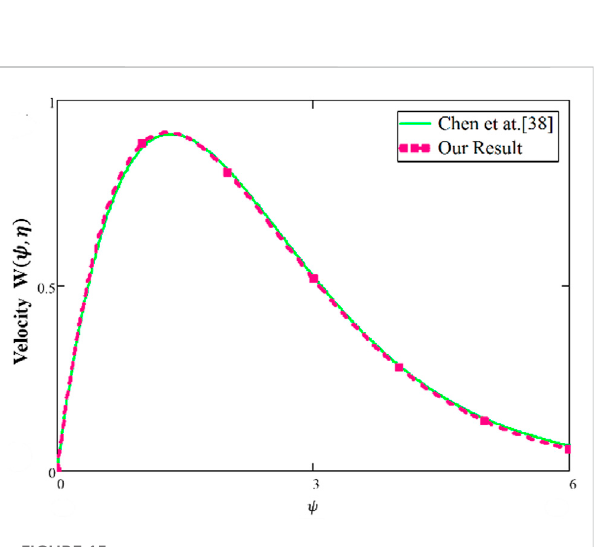
and no-slip conditions. It can be seen that the slip condition shows a lesser pro fi le for velocity than the no-slip conditions. Figure 14 shows the temperature and velocity behaviors for the comparison of